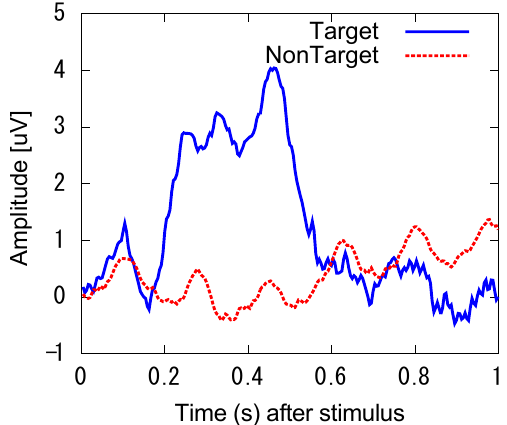
Figure 6. Examples of event-related potentials: P300 waveforms. The illustrated signals were averaged over 85 trials. “Target” is the observed signal corresponding to the subject’s perception after displaying a stimulus. “Non Target” is the observed signal corresponding to the subject’s perception corresponding to a stimulus ignored by the